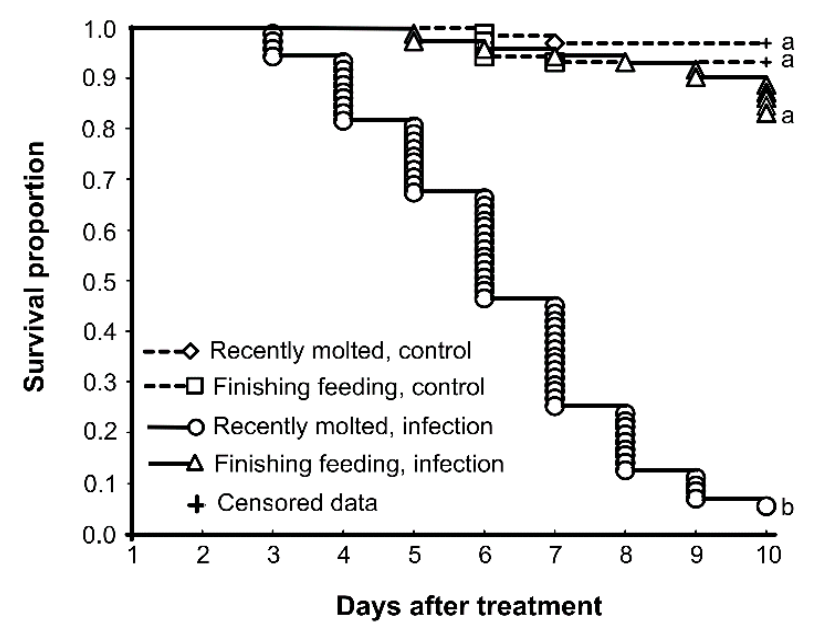
Figure 1. Survival of CPB larvae at different stages after topical infection with M. robertsii (5 × 10 6 conidia/mL). Recently molted larvae were infected at 2 h post-molt in instar IV. Finishing feeding larvae were infected at 86 h post-molt in instar IV. Different letters show significant differences in survival dynamics (log rank test, χ 2 > 110.3, df = 1, p < 0.0001).